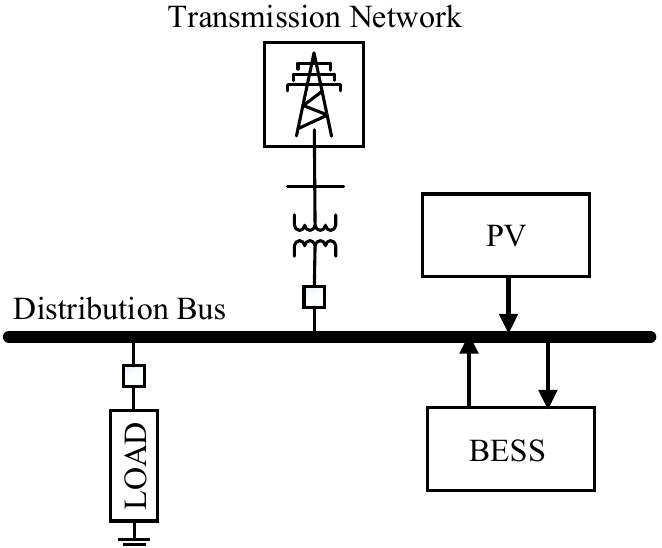
Figure 1. A typical structure of distribution networks (DN) with photovoltaics (PV) and battery energy storage systems (BESS).